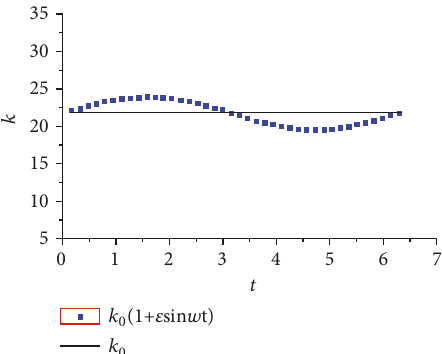
Figure 4: The curves of 𝑘 , 𝑘 = 𝑘 0 (1 + 𝜀 sin 𝜔𝑡) , for periodic disturbance( 𝜀 = 0.1 )andundisturbed( 𝜀 = 0 ),where 𝑘 0 = 21.7, 𝜔 = 1